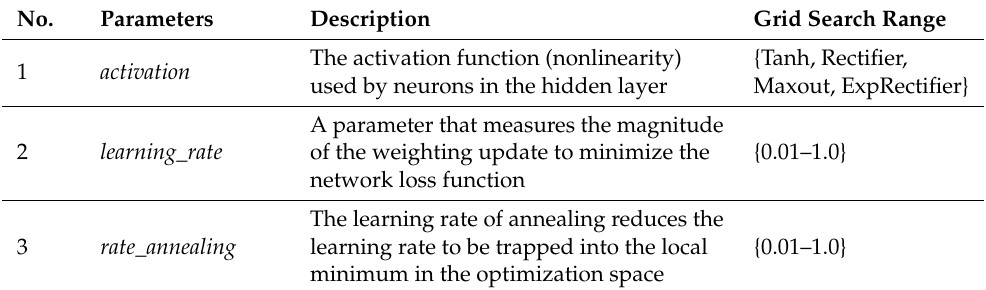
Table 4. ANN model parameter settings.